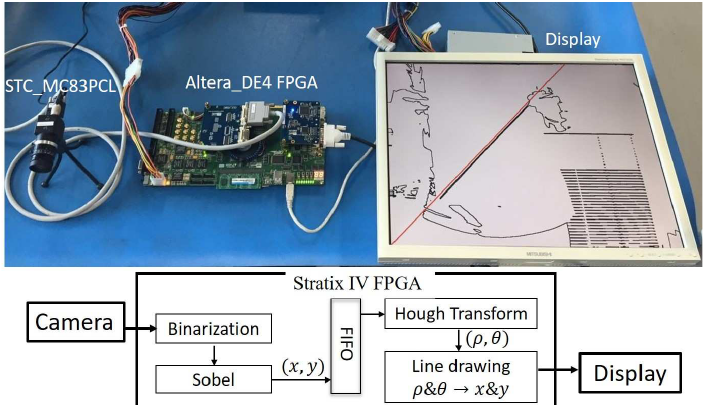
Figure 6. Prototype system for Hough transform (HT)-based straight-line detection.